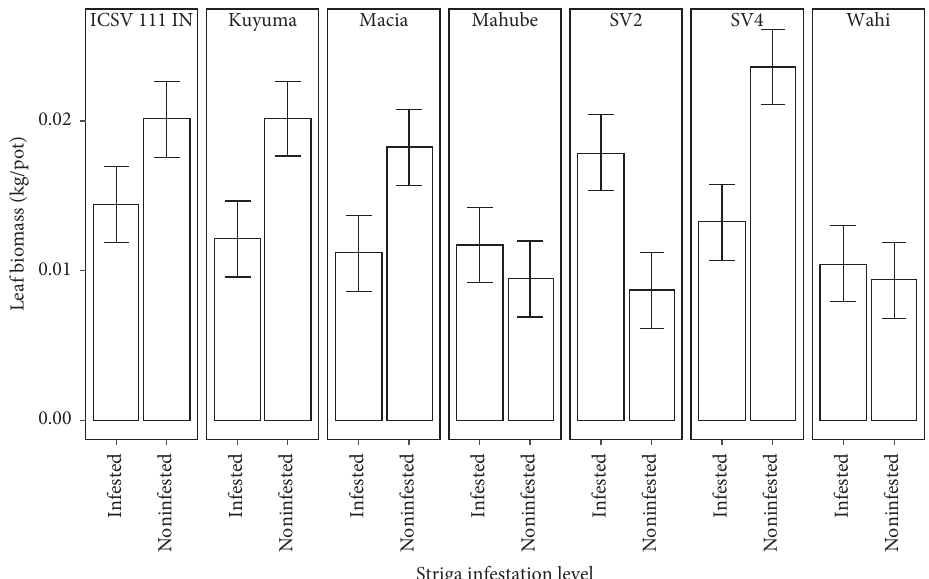
Figure 5: Interaction effects of sorghum genotype and Striga infestation on sorghum leaf biomass (kg pot − 1 ). Error bars represent LSD at p < 0 .